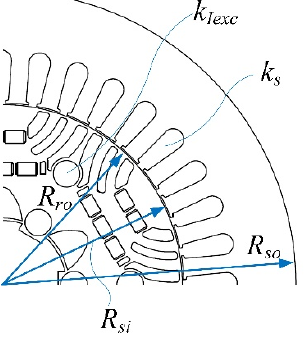
Figure 2. Design variables of HEPMa-SynRM.